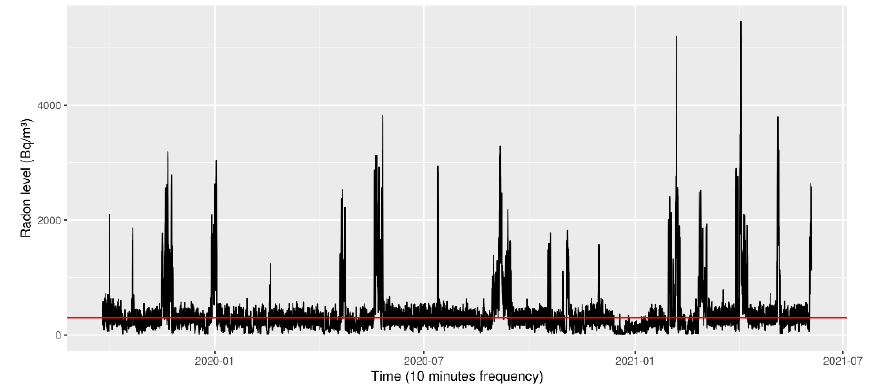
Figure 1. Course of radon over time.